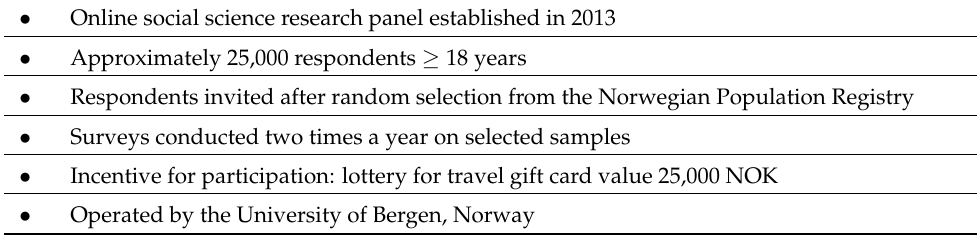
Table 1. The Norwegian Citizen